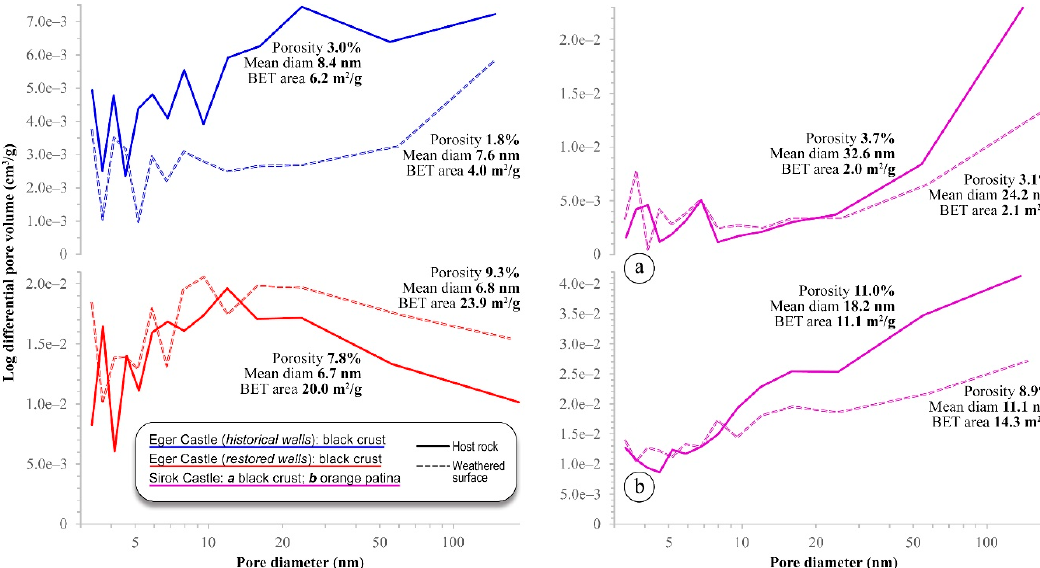
Figure 8. Pore-size distribution, porosity, mean pore diameter, and BET surface area of the studied tuffs, measured by N 2 adsorption separately on the host rock (continuous lines) and the weathered surface (dashed lines). Left graphs show samples of Eger Castle, right graphs of Sirok Castle